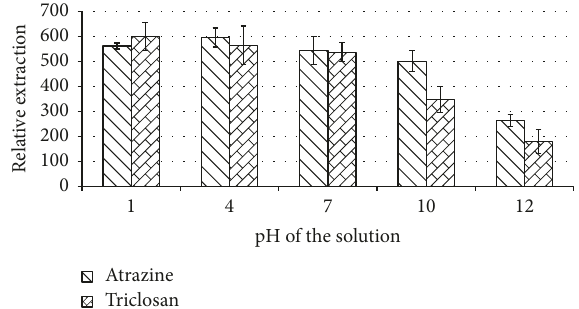
Figure 4: The effect of pH of the aqueous solution on extraction. Conditions: volume, 1mL of 5 𝜇 g/mL atrazine and triclosan aqueous sample to which 15mg NaCl was added (15% w/v); 25 𝜇 L of a 1: 4 (v/v) chlorobenzene :ethyl acetate mixture with the extraction time of 20 minutes and with toluene as the acceptor